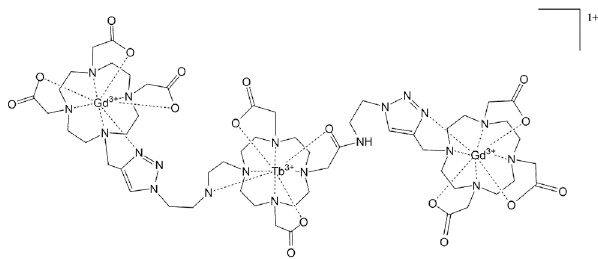
Figure 1. Open trimeric heterolanthanide complex.